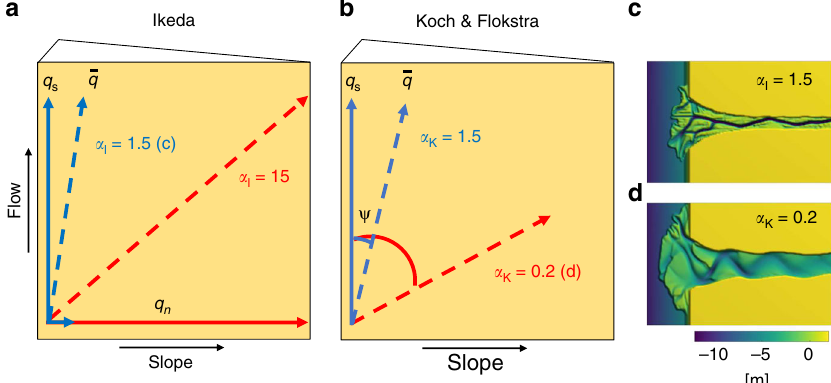
) and Koch and Flokstra 28 I and thereby increases the resulting sediment transport vector. I . α is roughly the inverse of α . K K I = 1.5) and into α . c , d Examples of a modeled river delta for default ( α K I I